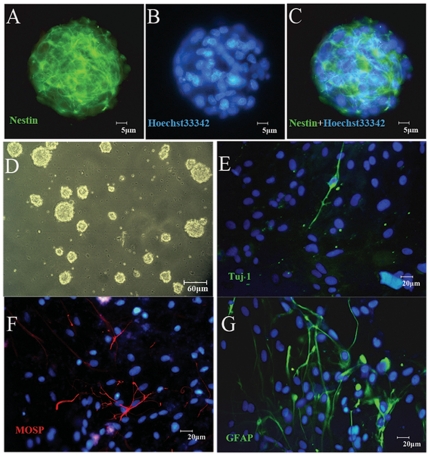
Neurosphere culture derived from the rat hippocampus.(A–C) Neurosphere at the second passage is immunoreactive to nestin, a marker of neural stem cells (green), and counterstained by nuclear fluorescent stain Hoechst33342 (blue). (D) Hippocampal cells from newborn rats proliferated and aggregated to form neurospheres one week after cultured in the DMEM/F-12 serum-free medium supplemented with B27 and bFGF. (E–G) Cells from the neurospheres show positive immunoreactivity to Tuj1 (E), MOSP (F), and GFAP (G) (markers of differentiating neurons, oligodendrocytes and astroglia, respectively) one week after cultured in the differentiation medium (DMEM/F12+10% FBS).